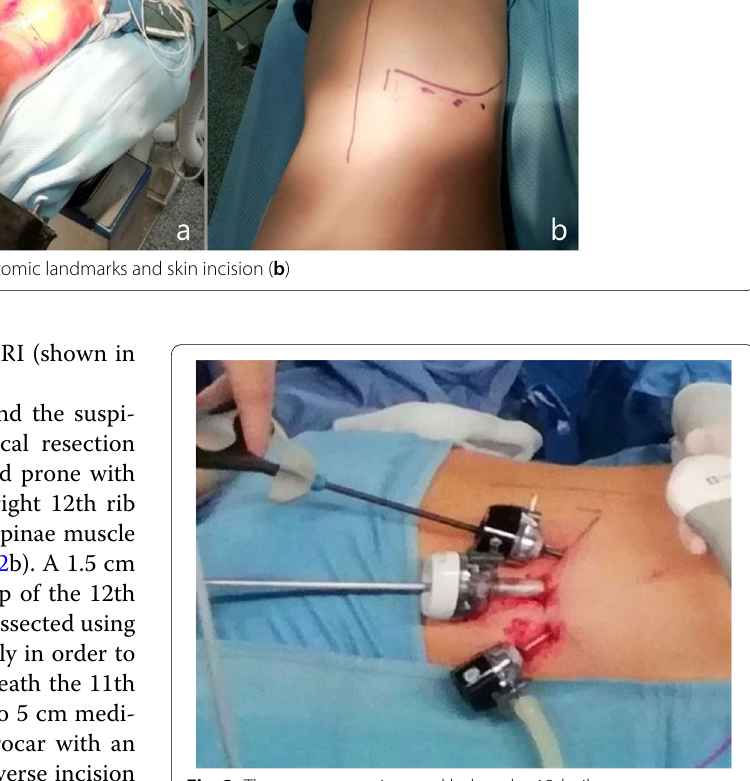
Fig. 3 Three trocars are inserted below the 12th